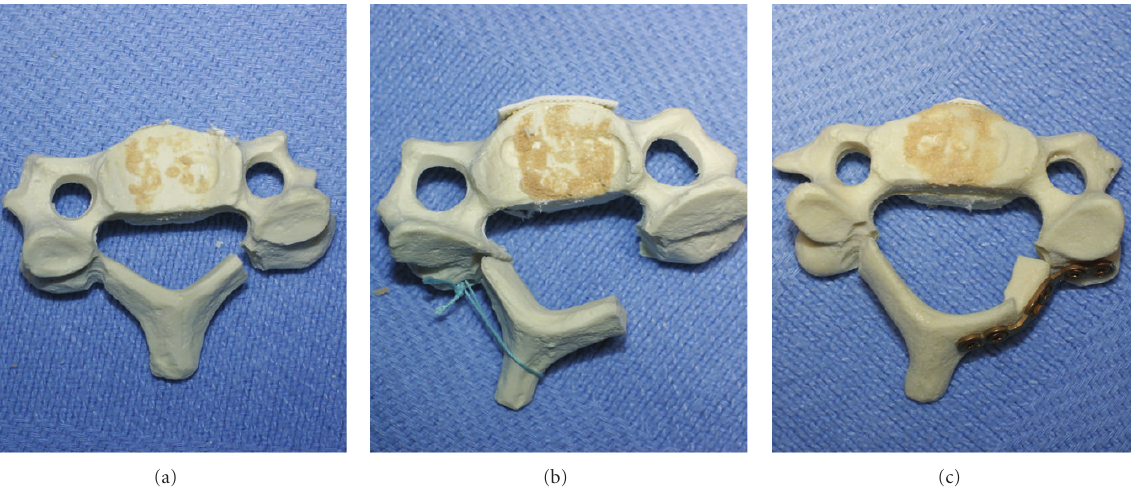
Figure 8: Sawbones model showing an increase in A-P diameter of the canal between the preexpanded status (a), after suture anchor laminoplasty (b), and after laminoplasty with miniplate fixation (c).